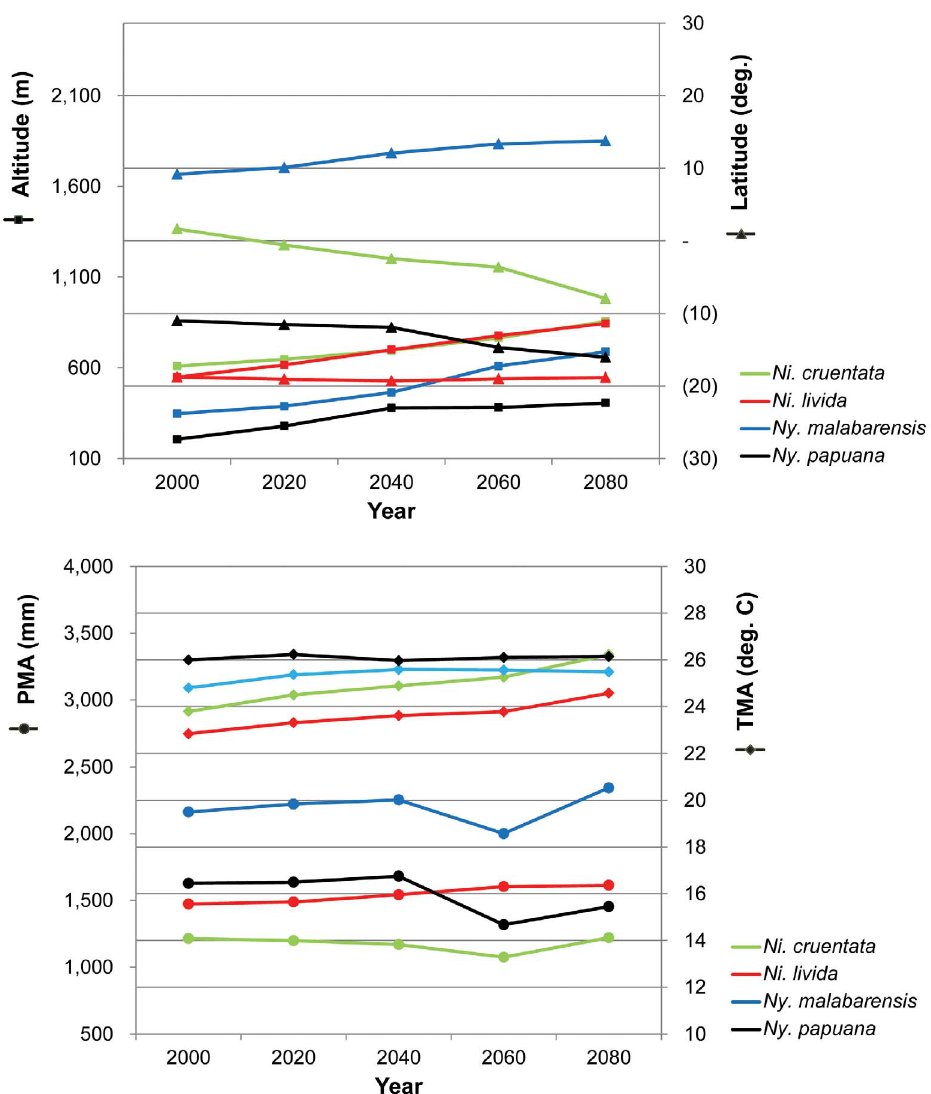
Figure 3. Changes for all species in altitude and latitude (above), and temperature and precipitation (below). Species maintain their characteristic climatic conditions by shifting towards higher altitudes and latitudes. Geographical and ecological averages for the modeled suitable habitats combined all categories (low, medium and high suitability). NI= Nephilingis , NG= Nephilengys , PMA=mean annual precipitation, TMA= mean annual